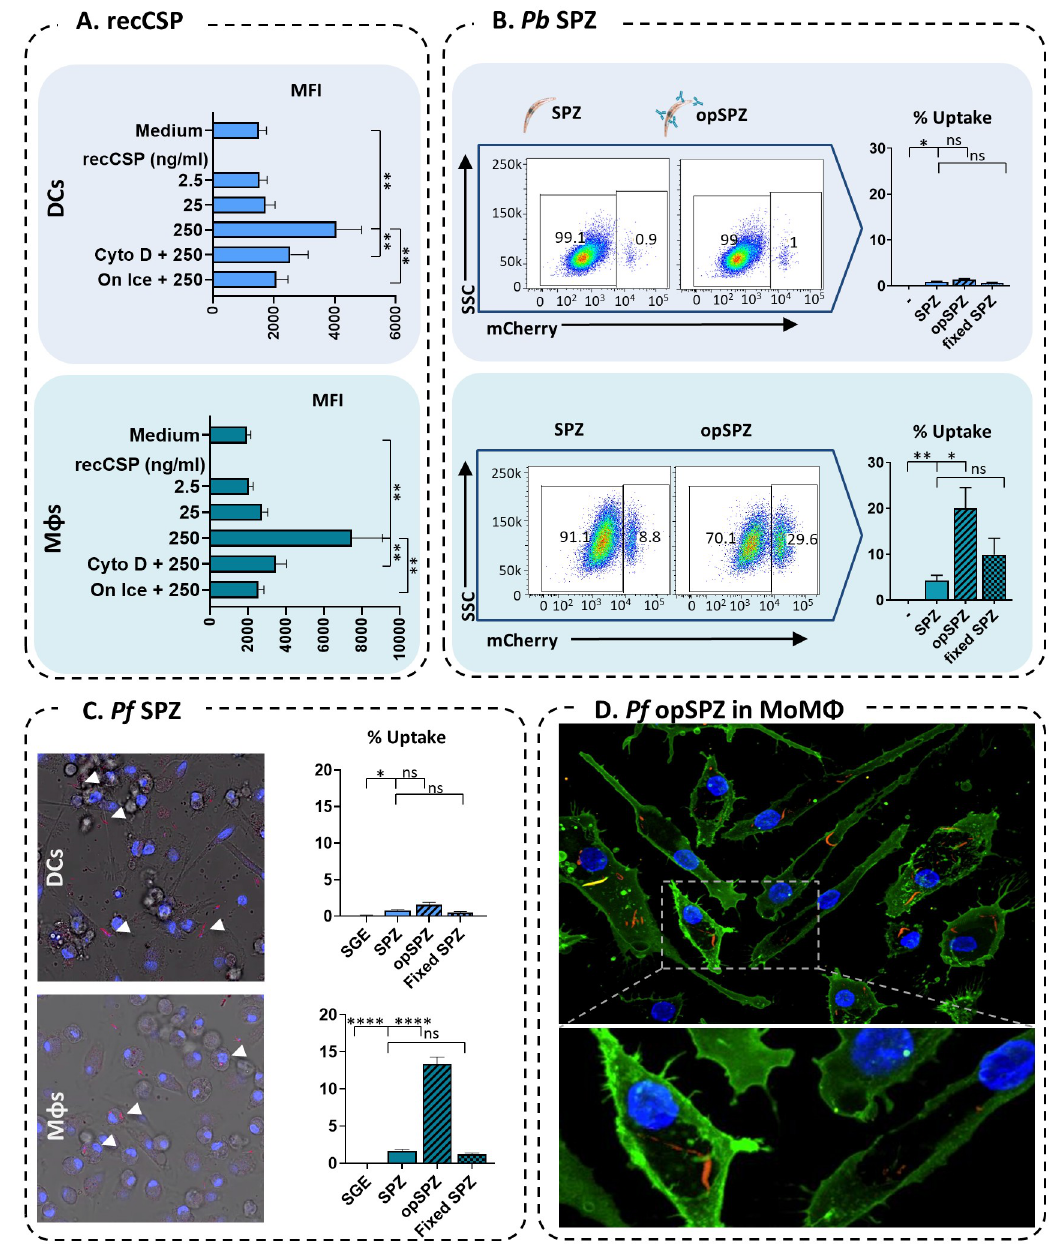
Fig 2. Uptake of recCSP and whole SPZ by MoDCs and MoM ϕ s. A . Quantification of fluorescent recCSP uptake (ng/ml) in MoDCs (top) and MoM ϕ s (bottom); MFI: median fluorescence intensity. N = 2, 4 donors. B . Uptake of whole Pb sporozoites by MoDCs and MoM ϕ s. Representative flow cytometry plots showing mCherry expression in MoDCs (top) and MoM ϕ s (bottom) after stimulation with SPZ or opsonized SPZ using an anti-CSP antibody (opSPZ). Quantification of SPZ uptake (% of mCherry + APCs) by flow cytometry. N = 3, 9 donors (fixed SPZ: 4 donors). C . Uptake of whole Pf sporozoites by MoDCs and MoM ϕ s quantified by confocal microscopy. N = 2, 4 donors, on average 1150 MoMacs and 550 MoDCs per donor per condition. D . Confocal microscopy image of Pf SPZ uptake by MoM ϕ